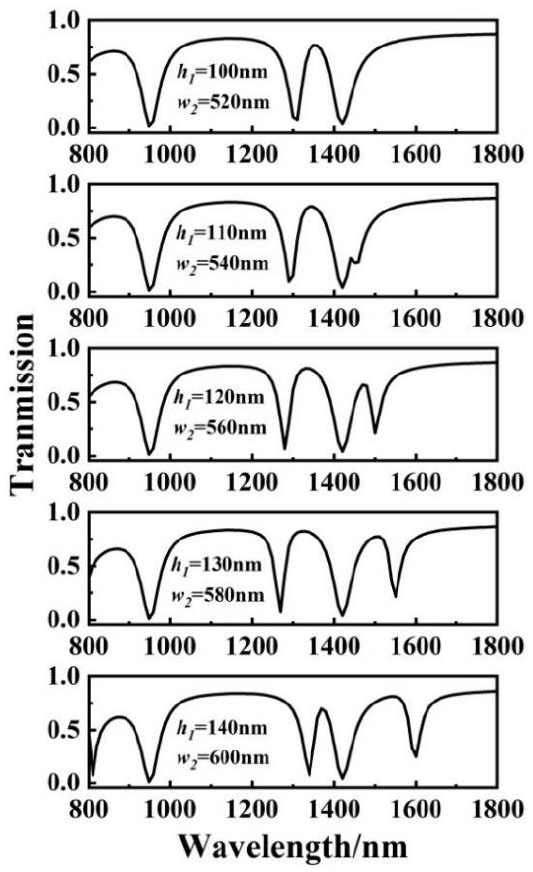
Figure 6. Off-to-on transmission spectra of the three-rectangle-resonator PIT system with different values of h 1 and w 2 .